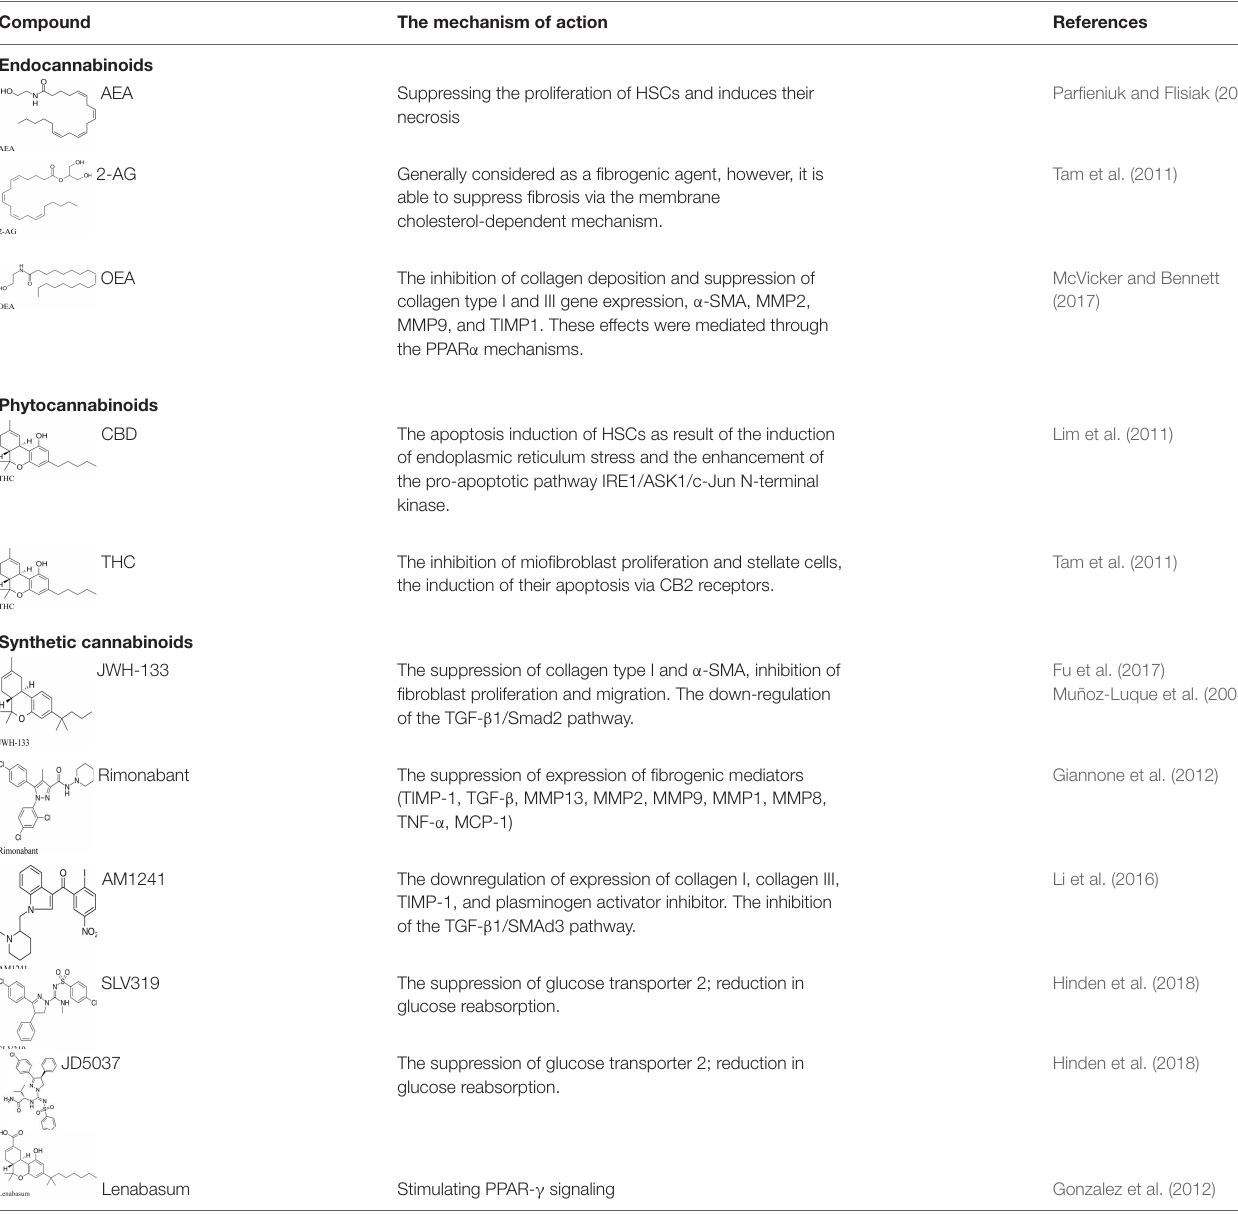
TABLE 4 | Anti-fibrotic effect of